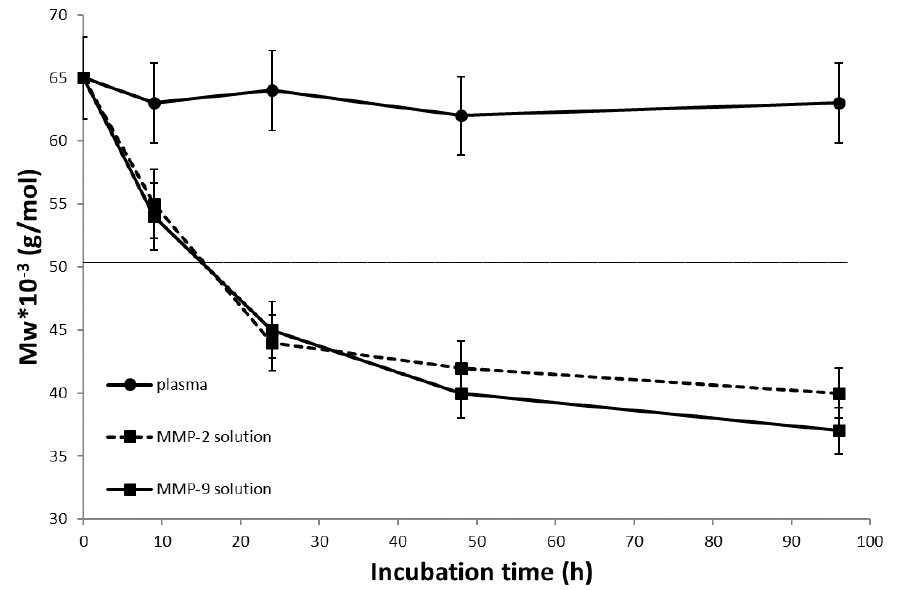
Figure 4. The time course of M w of diblock polymer precursor D- PVGLIGK -THP during their incubation in buffers containing MMP-2 or MMP-9 (3 µM) or in human plasma (37 °C). Values are mean ± S.D. ( n = 3).